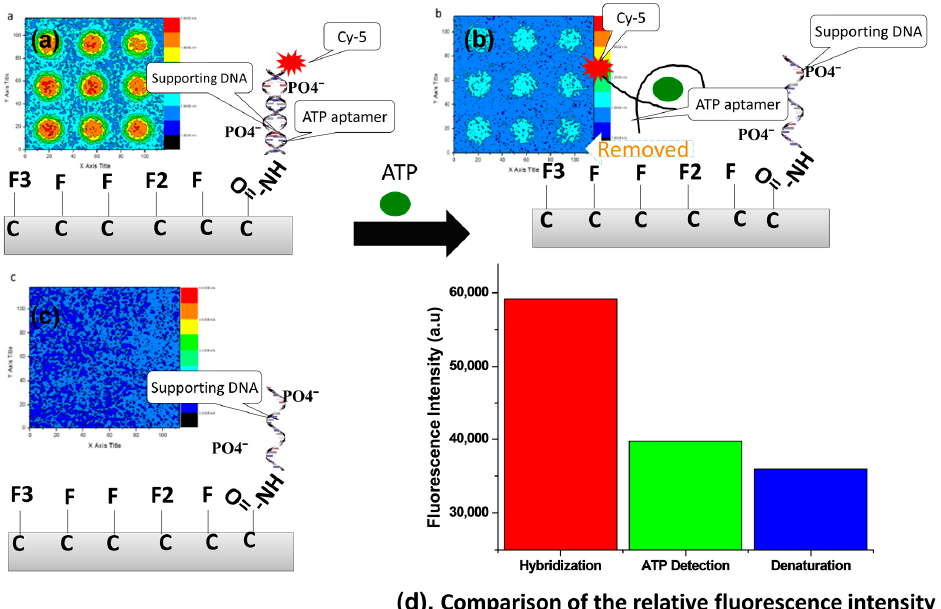
Figure 5. Fluorescence signals at different steps of the sensor operation. ( a ) Hybridization of the supporting DNA with the aptamer modified with Cy-5 as a fluorescent indicator; ( b ) ATP detection via the aptamer; ( c ) Denaturation, which occurred when ATP and the aptamer were removed from the sensor and the DNA became single stranded; ( d ) Comparison of the relative fluorescence intensities at the three observation points for similar areas.